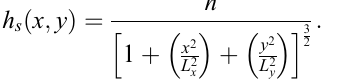
Fig. 10. Field of vertical velocity in the control simulation, for 2D non-linear, hydrostatic mountain waves; contour interval is 0 : 05ms (cid:255) 1